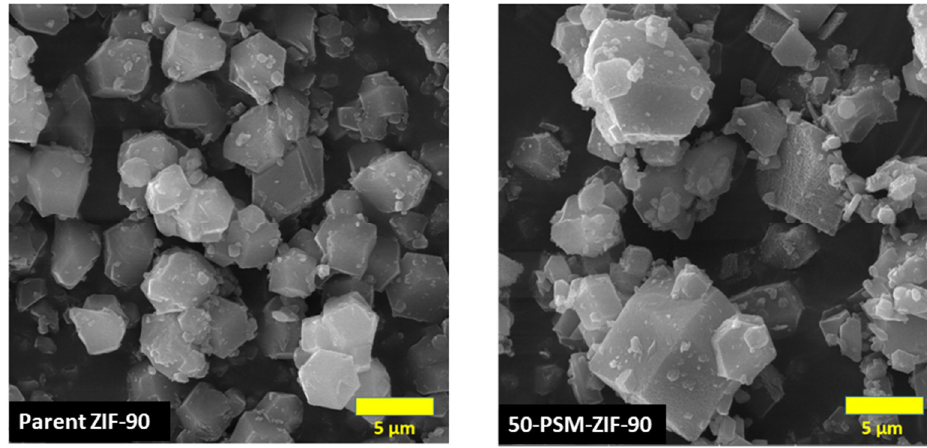
Figure 4. FESEM images of ZIF-90 and 50-PSM-ZIF-90.